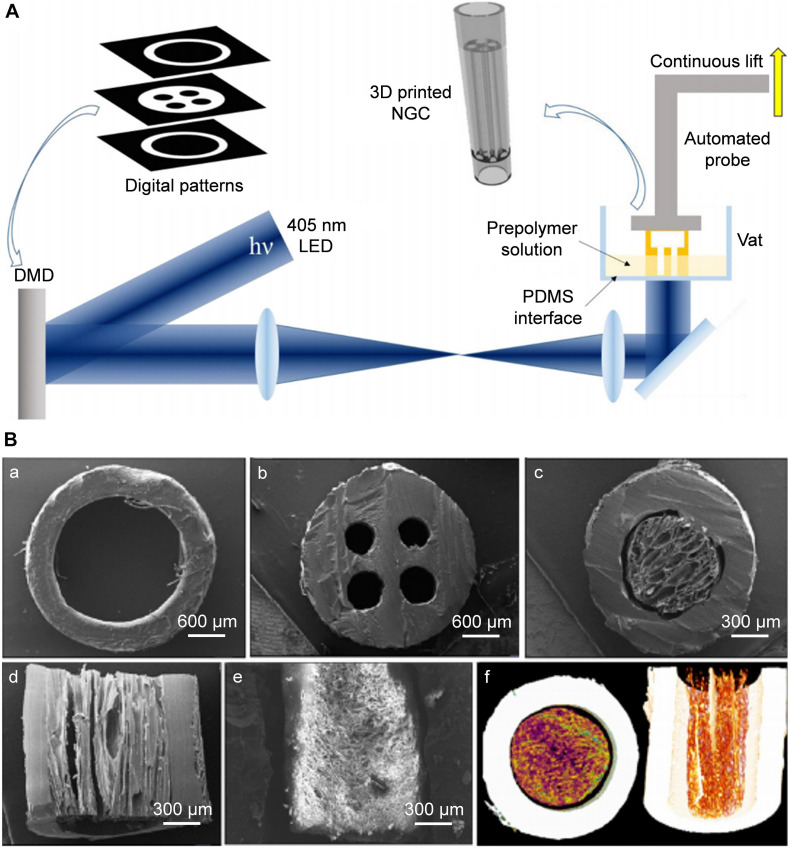
Rapid continuous 3D printing. (A) Schematic diagram of the rapid continuous 3D printing (Zhu et al., 2018). (B) SEM images of complex structured NGCs transverse sections of hollow (a), 4-multichannel (b), aligned cryomatrix-filled NGC (c,d), random cryomatrix-filled (e), Micro-CT image of aligned cryomatrix-filled NGC (f) (Singh et al., 2018). (A) Reproduced with permission from Zhu et al. (2018) and (B) Reproduced with permission from Singh et al. (2018).